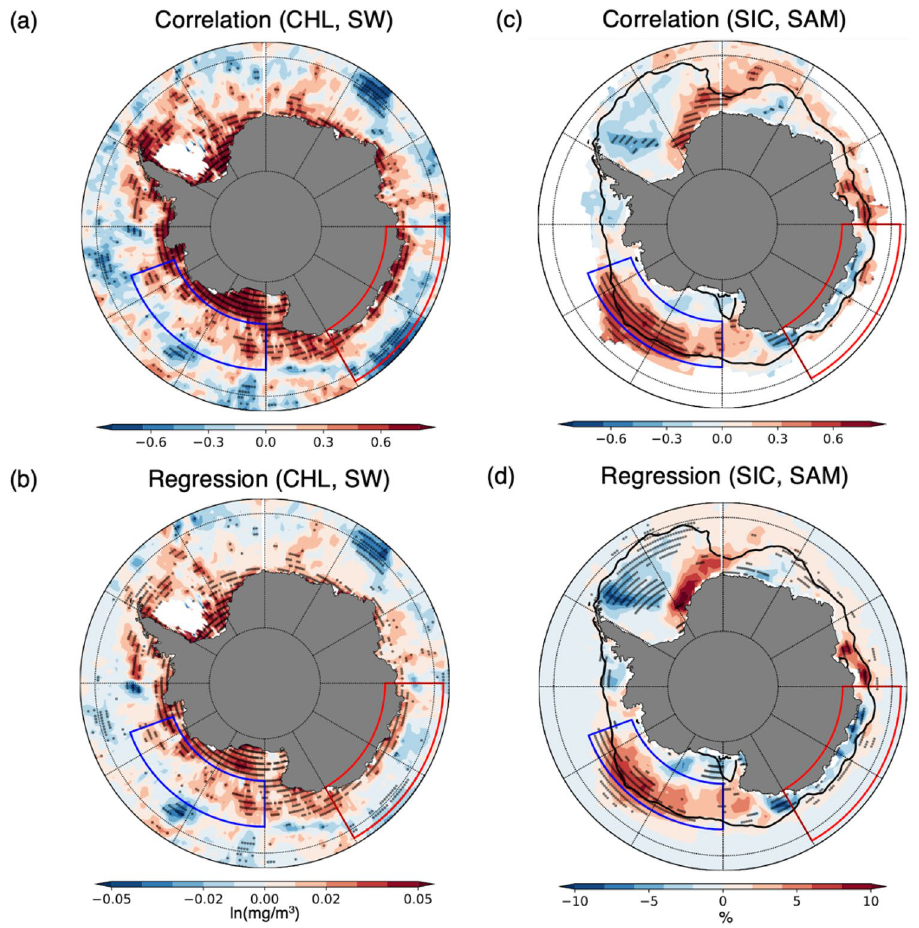
Figure 2. Correlation and regression maps ( a , b ) between the chlorophyll concentration and net shortwave flux on the ocean surface and ( c , d ) between the SAM index and sea ice concentration. The thick solid line, which is the 15% sea ice concentration line, represents the climatological mean sea ice extent and the 95% significant correlation ( p value < 0.05) regions are denoted by black dots. White areas indicate the region where satellites have not observed chlorophyll for at least three years due to sea-ice cover or